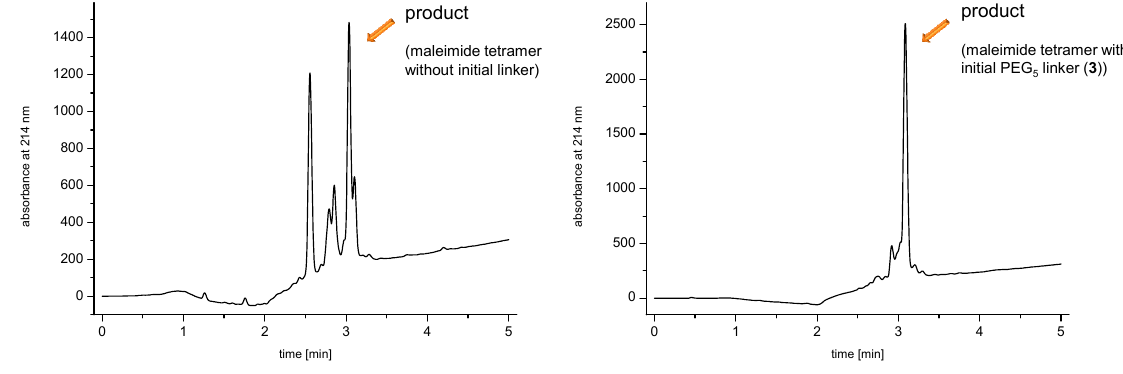
Figure 3. Observed product purities of the cleaved raw materials ( a ); and schematic depiction of the structures of the tetravalent maleimides 1 – 10 ( b ). Product purities were determined by analytical